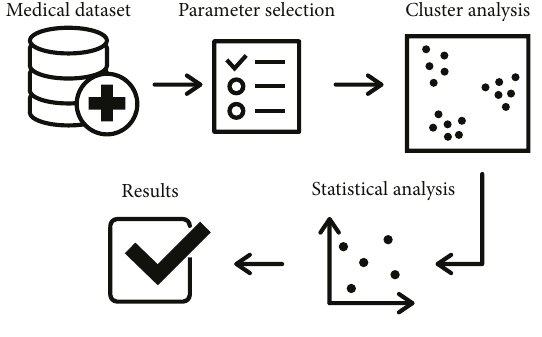
Figure 1: Overview of the